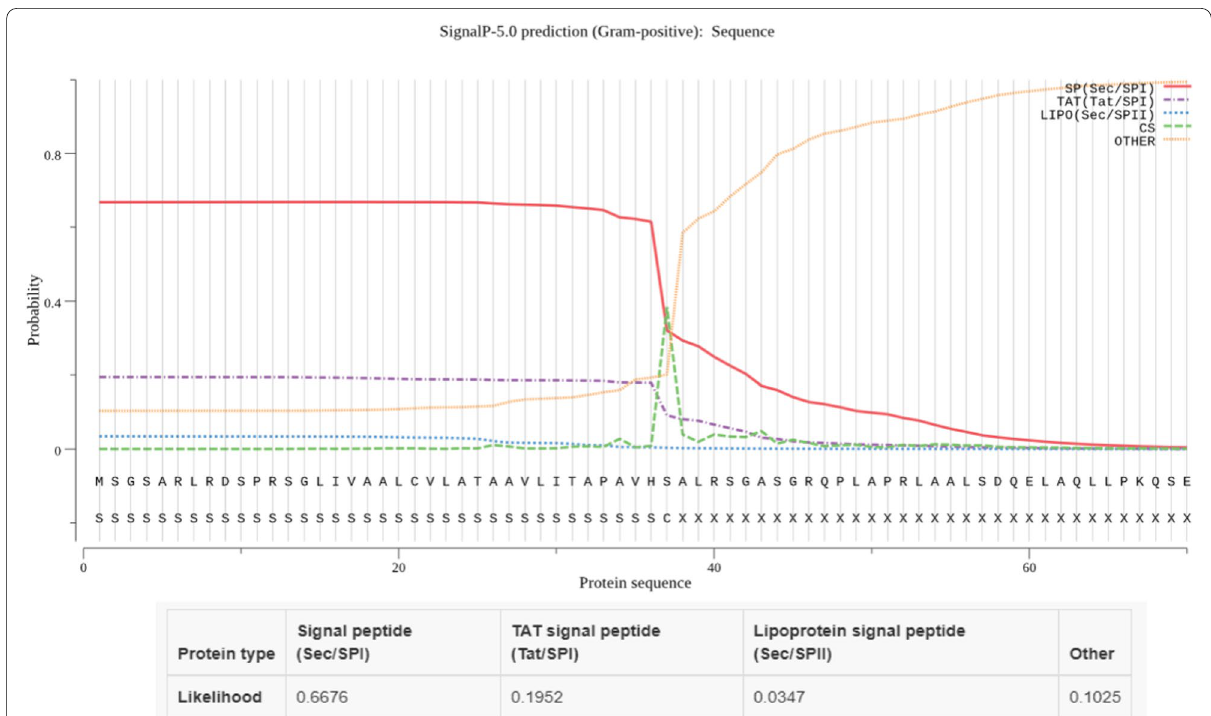
Fig. 3 Graphical representation of the presence of signal peptide (sec/spl) with a cleave cite between 37 and 38 amino acids of the NHP1 protein using SignalP